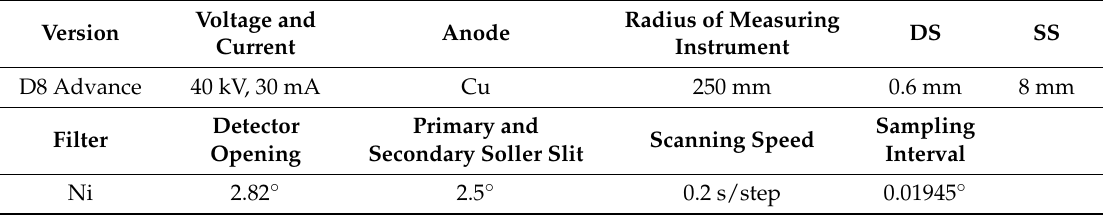
Table 1. The main parameters of the X-ray diffraction instrument and test